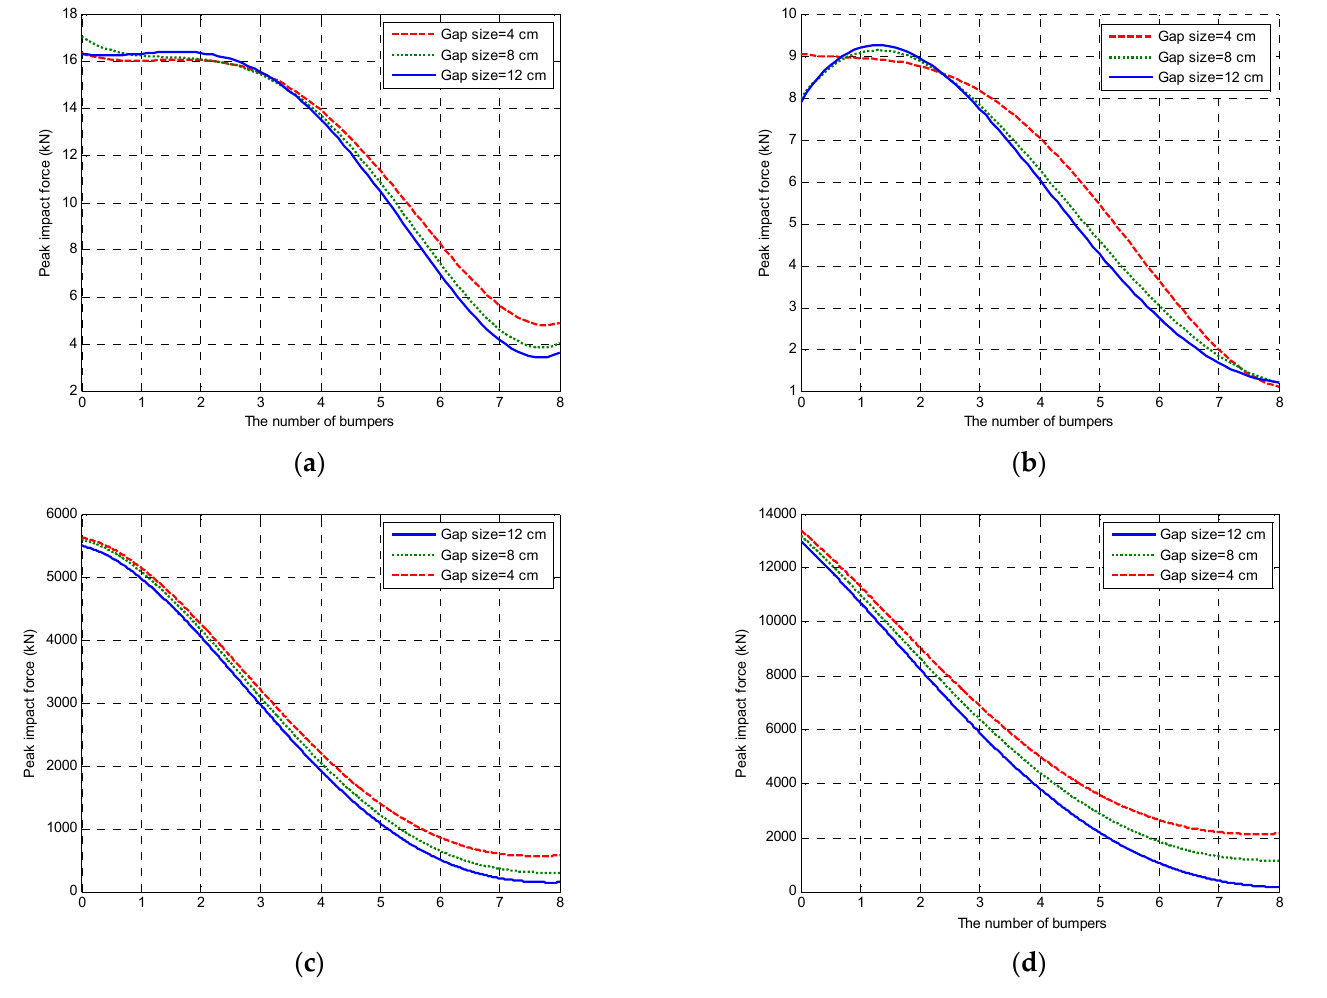
Figure 13. Peak values of impact force for different numbers of rubber bumpers and gap sizes under different seismic excitations: ( a ) Parkfield; ( b ) Kobe; ( c ) San Fernando; ( d ) Tabas.